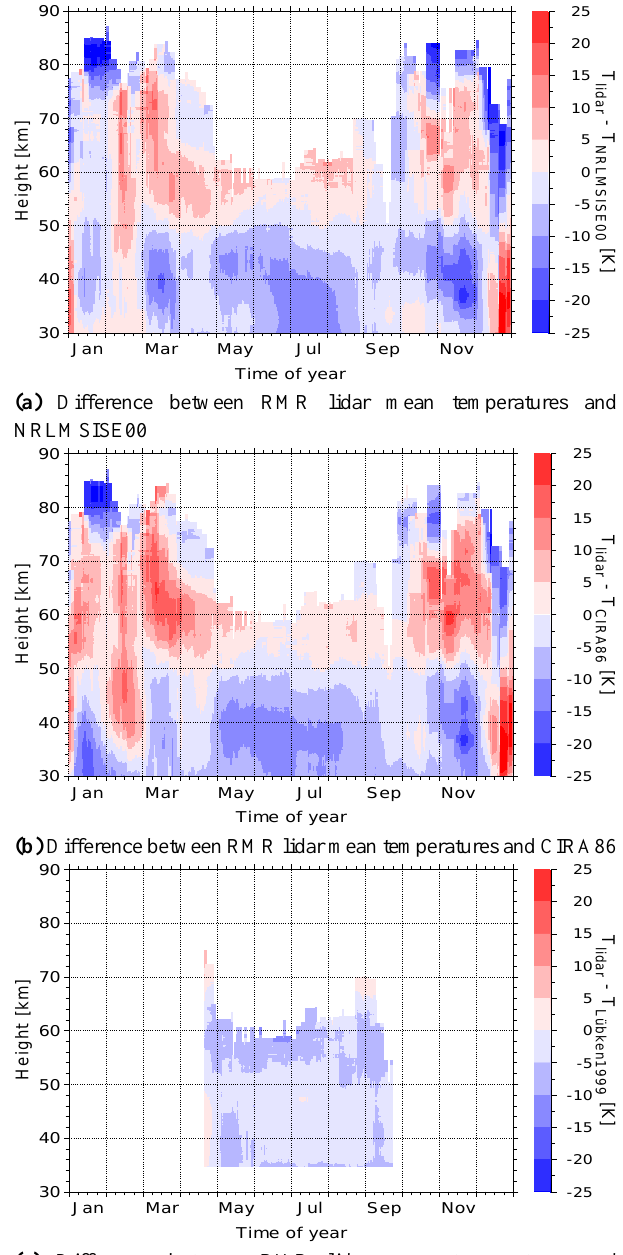
Fig. 9. Upper panel: Comparison of RMR lidar temperatures to the NRLMSISE00 reference atmosphere at 69 ◦ N. Middle panel: Comparison of RMR lidar temperatures to the CIRA86 reference atmosphere at 70 ◦ N. Lower panel: Comparison to the L¨ubken1999 reference